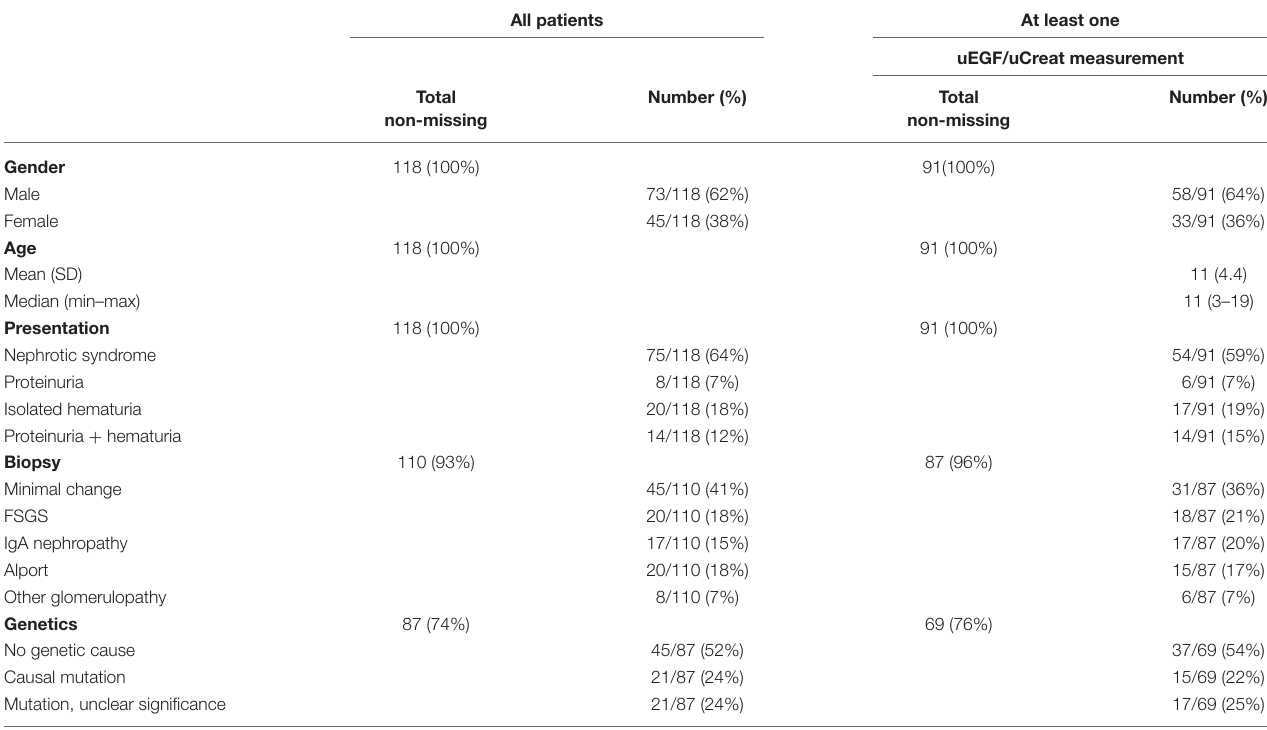
TABLE 1 | Overview of patients’ characteristics, clinical presentation, results of histology, and genetic screening.